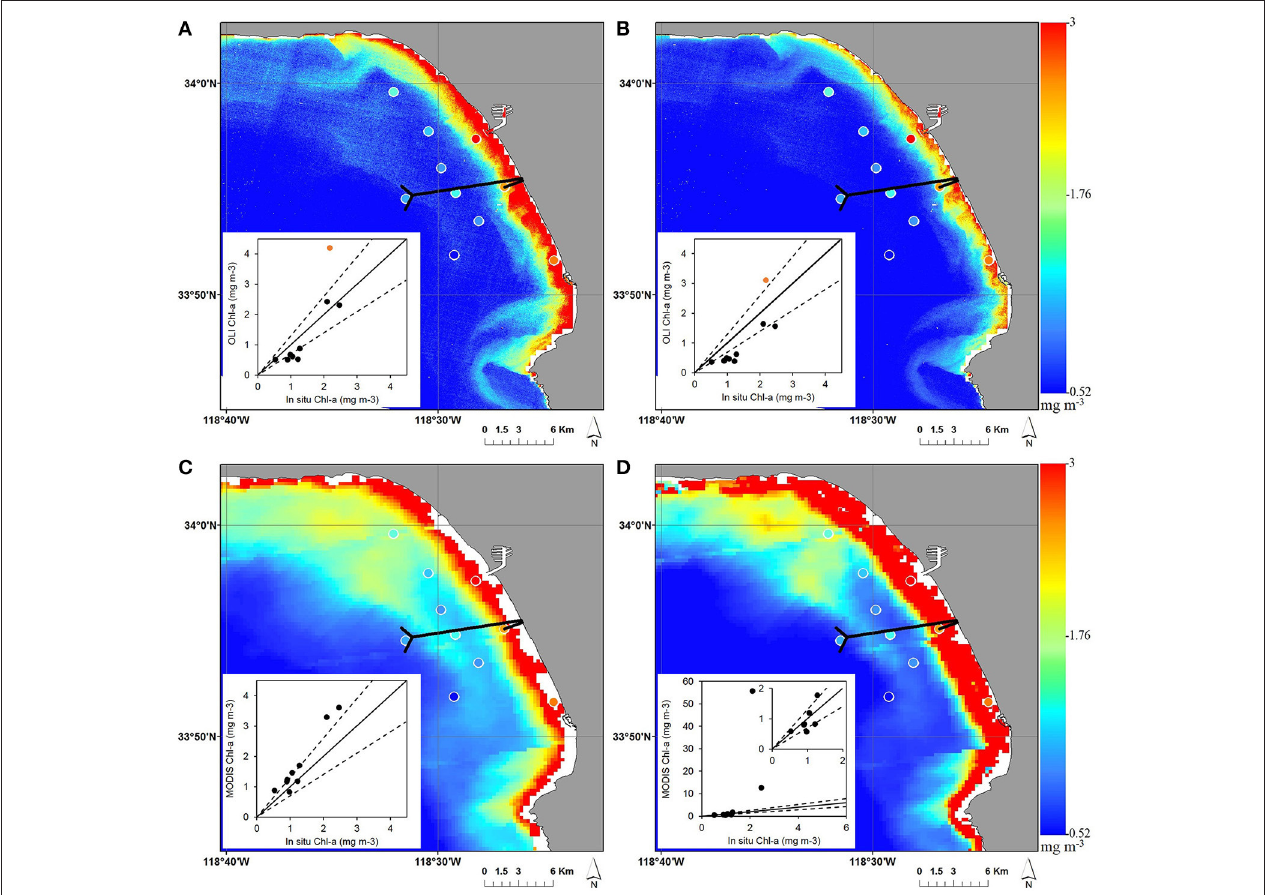
FIGURE 6 | Maps of chl-a concentrations on 11 November 2015, overlaid with 10 corresponding in situ chl-a measurements from sampling stations (denoted as circles using the same color scale as the satellite chl-a concentrations). (A) Local OLI chl-a algorithm. (B) Standard OC2 OLI chl-a algorithm. (C) Local MODIS